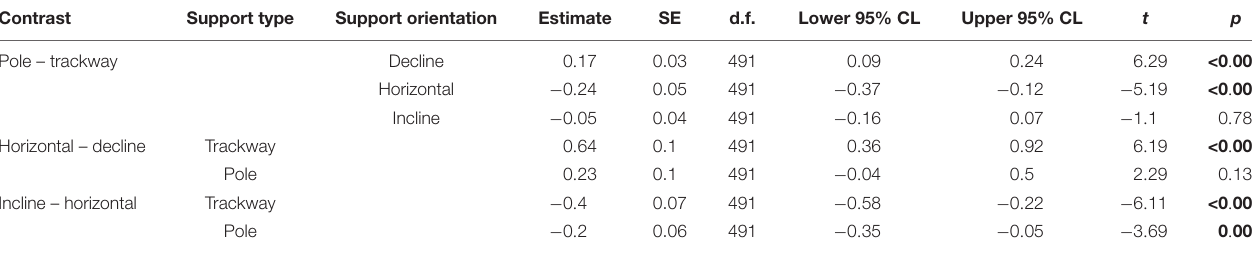
TABLE 2 | Post hoc contrasts for the regression of speed. Contrast Support